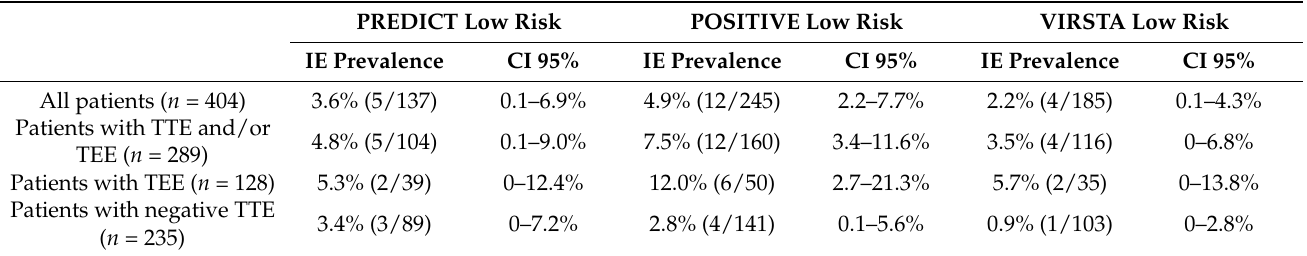
Table 4. IE rate among patients identified as low-risk by different scores in different population according to echocardiographic evaluation and